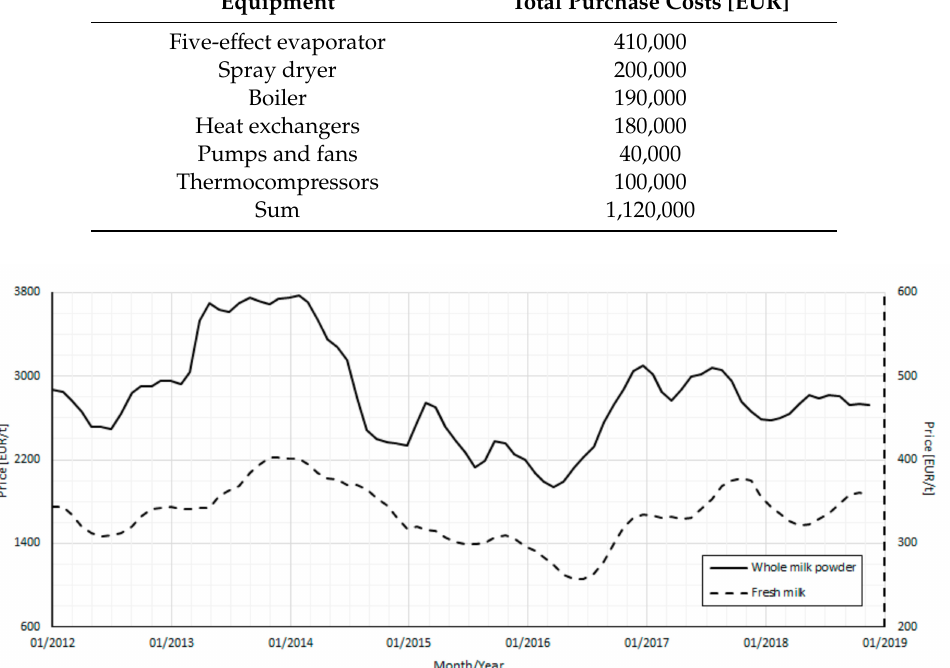
Figure 9. Development of fresh milk (dashed line) and whole milk powder (solid line) prices in European Union in